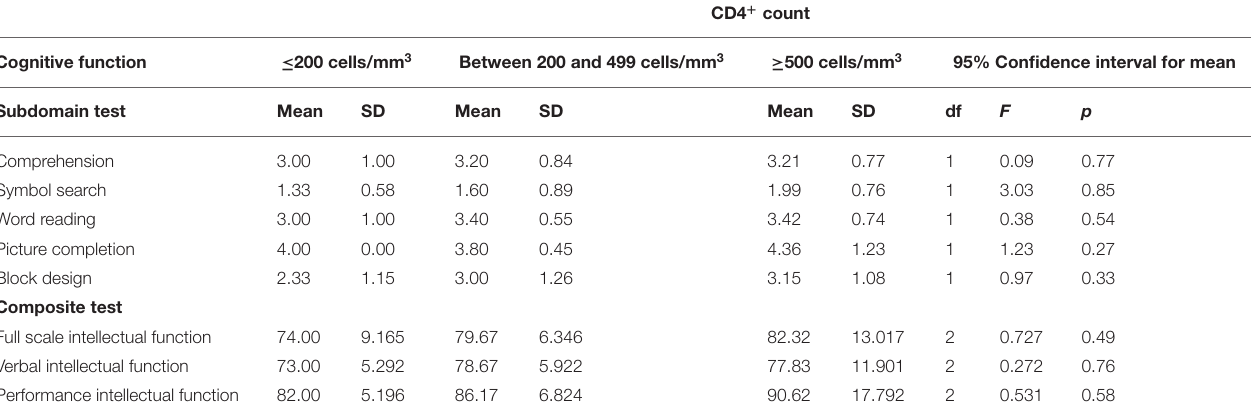
TABLE 4 | One-way ANOVA results for CD4 + lymphocyte levels cells/mm 3 , subdomains, and composite cognitive function in the study of HIV-positive